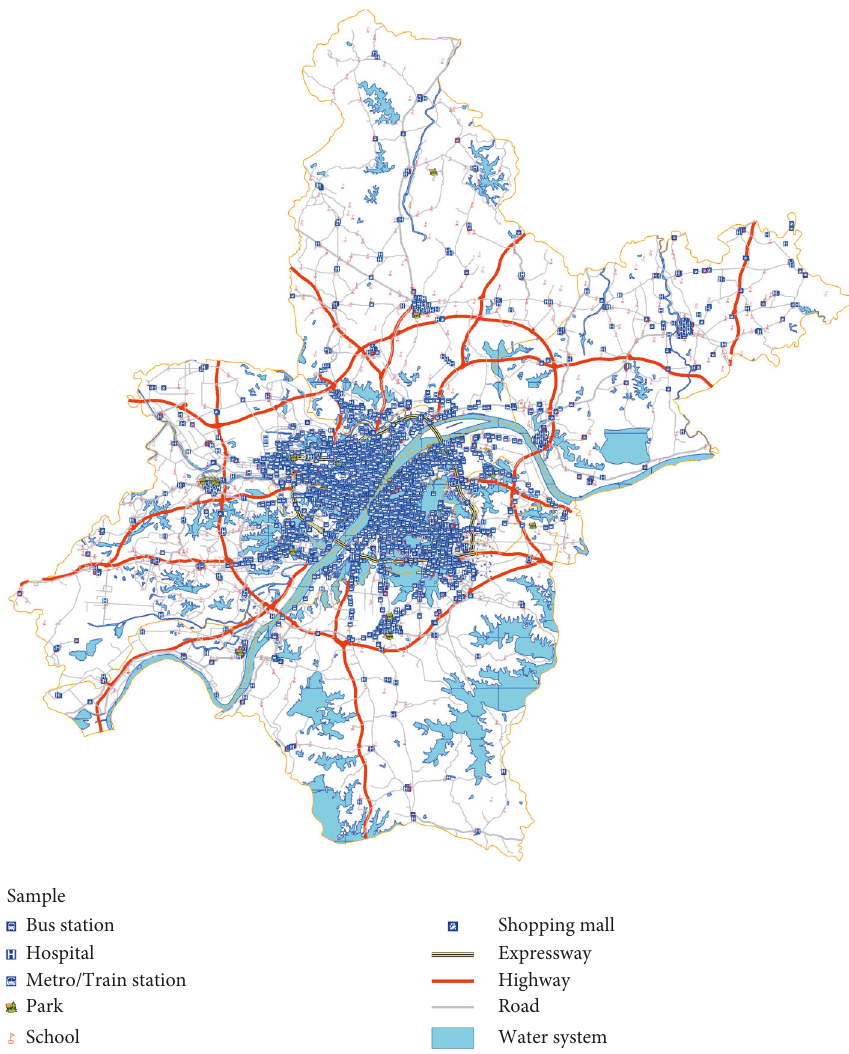
Figure 2: Electronic vector map of Wuhan. Table 4: Factor